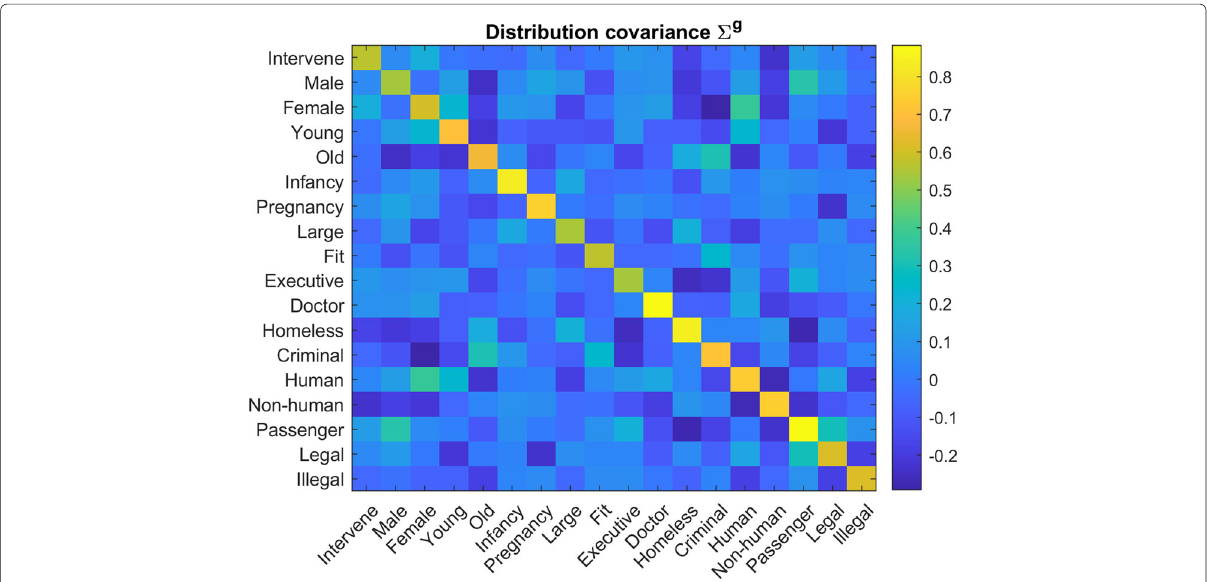
Fig. 4 Moral Principle Covariance: Covariance matrix for all underlying distributions of the moral principle vector